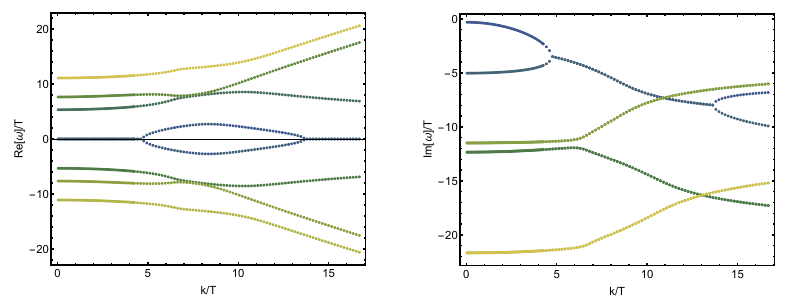
Figure 5 . A snapshot of the (cid:12)rst four modes in the transverse spectrum of the (cid:13)uid model (3.1). We (cid:12)xed m=T = 0 : 9525.